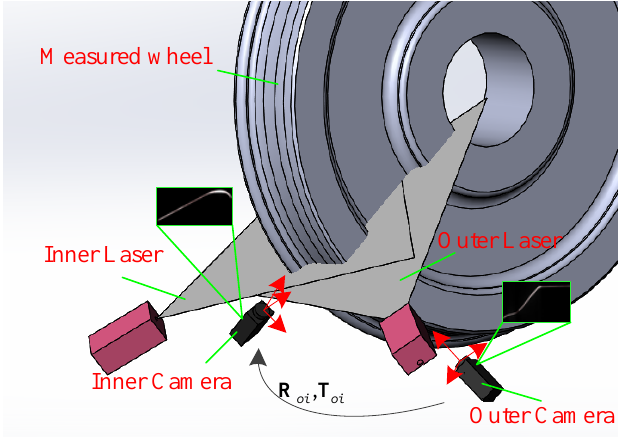
Figure 2. Layout of wheel profile acquisition sensors.